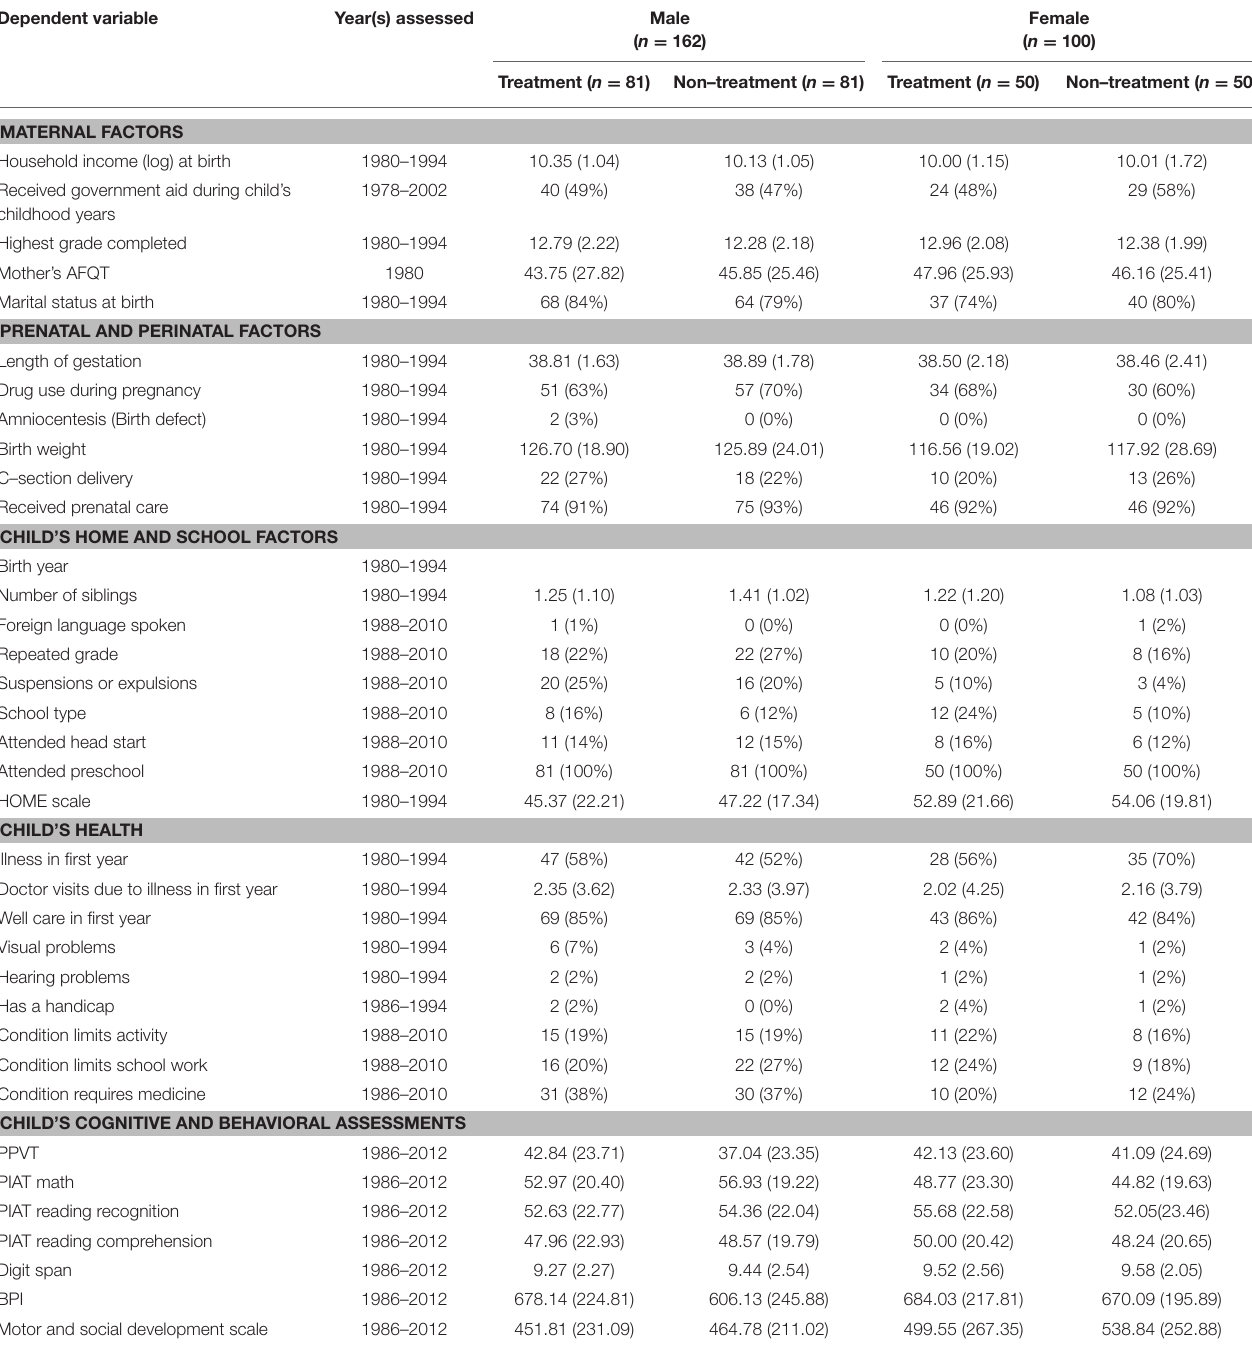
TABLE 1 | Dependent variables used in calculating propensity score and balance check for whites ( n =